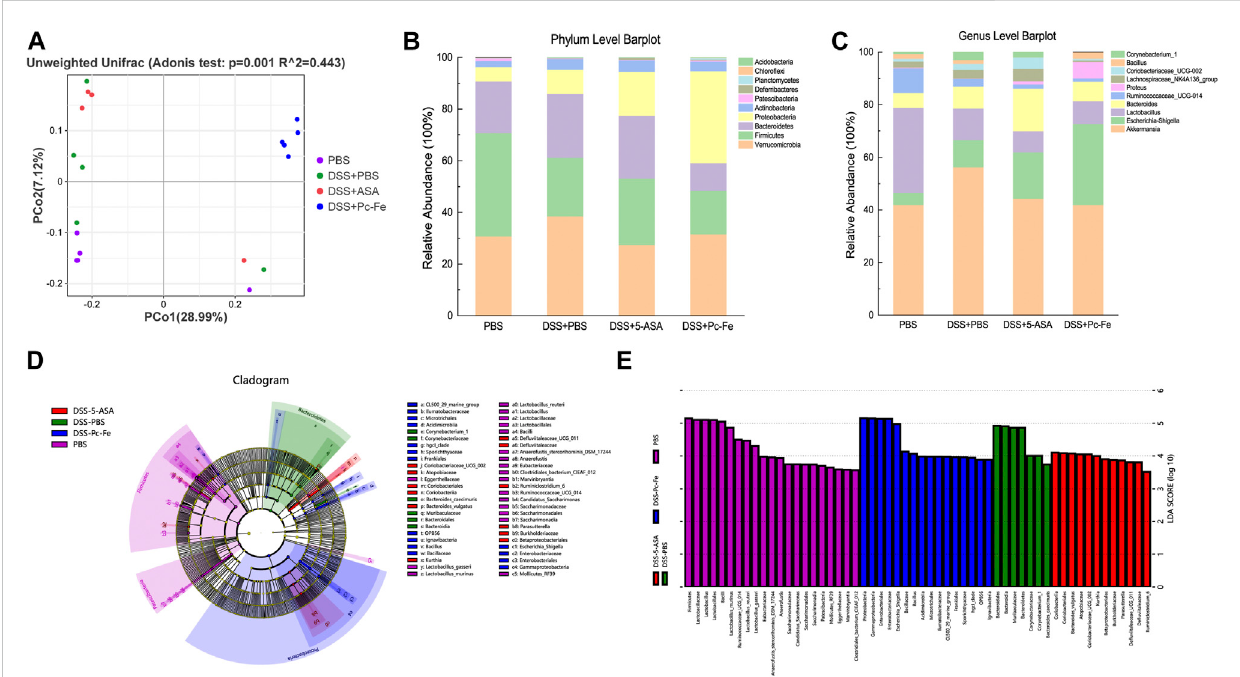
FIGURE 8 Diversity and composition of gut microbiota. (A) Weighted Unifrac PCoA analysis was utilized to distinguish bacterial clustering. The component proportionofthemicrobiomeatthephylum (B) andgenuslevel (C) amonggroupswasshown.Therelativeabundanceofgeneradifferencewasidenti fi ed via the Wilcoxon rank-sum test. The phylogenetic distribution in the PBS group, the DSS + PBS group, the DSS+5-ASA group and the DSS + Pc-Fe group was illustrated with a cladogram (D) and a histogram (E)